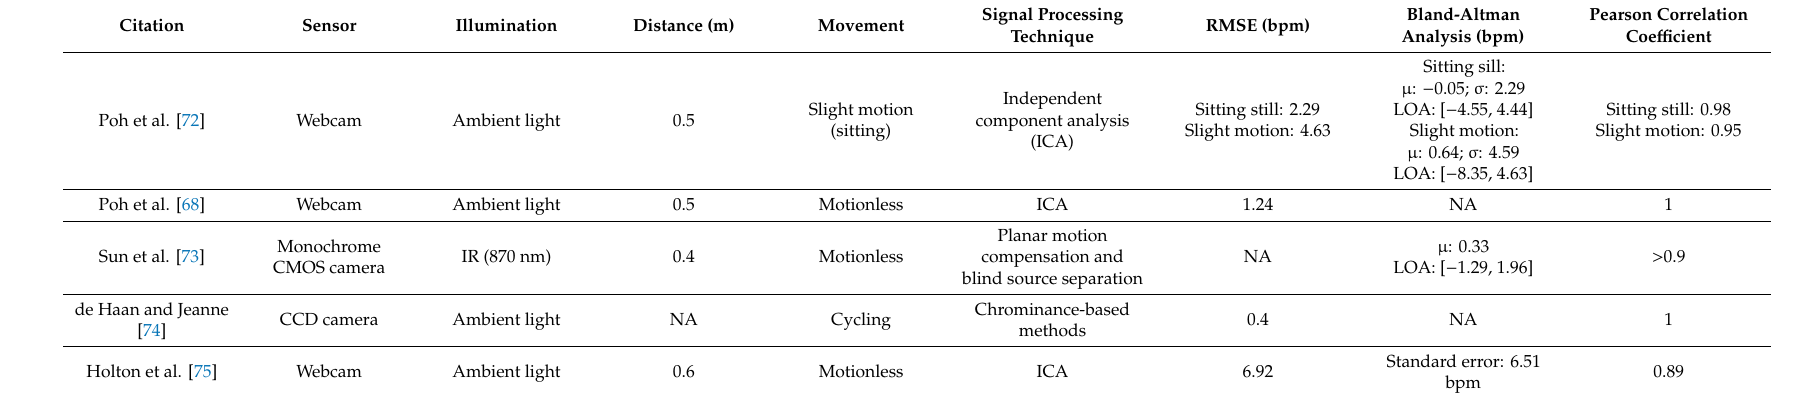
Table 6. Summary of photoplethysmographic imaging (PPGI) techniques for HR monitoring, part 1.